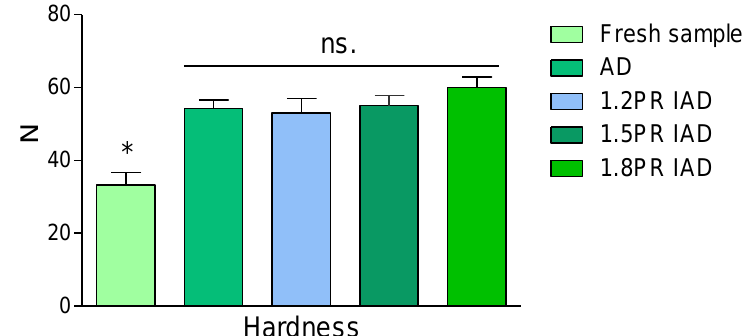
Figure 3. Hardness of samples dried by drying schemes with di ff erent pulse ratios. Note: AD is continuous air drying; 1.2 PR is an on 20 min and o ff 5 min pulse ratio of intermittent air drying, 1.5 PR is an on 20 min and o ff 10 min ratio of intermittent air dying, PR 1.8 is an on 20 min and o ff 15 min ratio;